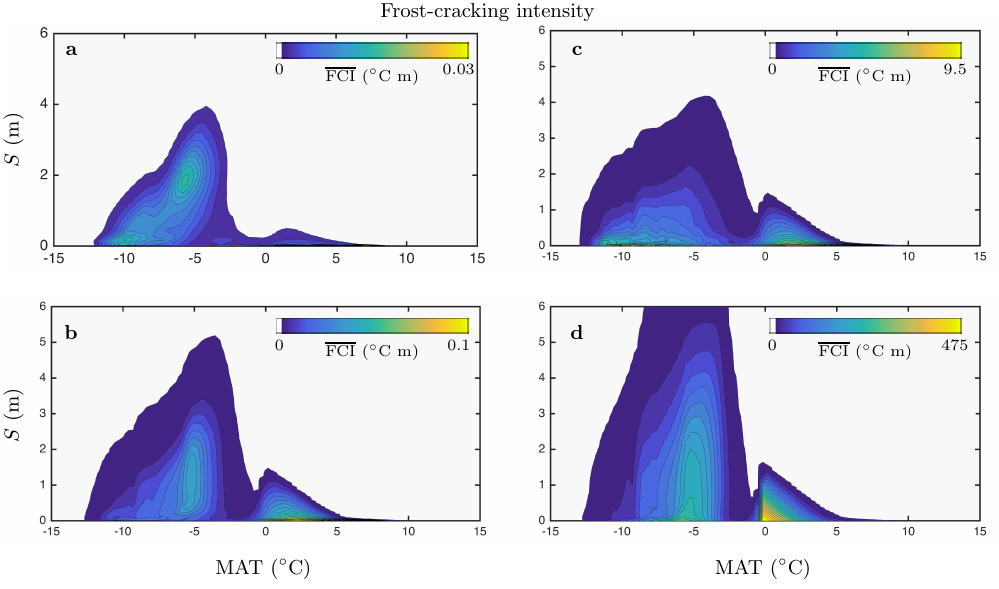
Figure 11. The integrated frost-cracking intensity as a function of sediment thickness and MAT, for varying water-penalty implementations. Panel (a) : our standard model (same as Fig. 5). Panel (b) : the distance to the water source and the amount of water available influences the penalty function, but in contrast to our standard model, the flow restriction parameters, γ , are constant (2m − 1 ) and independent of the porosity or thermal state. Panel (c) : flow restriction parameters are constant (2m − 1 ), and the distance between an element in the FCW and the nearest water source scales the FCI. Compared to our standard model, the FCI is unaffected by the amount of water available at the source (the porosity is not accounted for). This model implementation is similar to that of Anderson et al. (2012). Panel (d) : frost cracking occurs whenever water is present along the vertical profile in the direction of warming temperature, independent of the distance to, or amount of water available at, the source. This model implementation is similar to the model by Hales and Roering